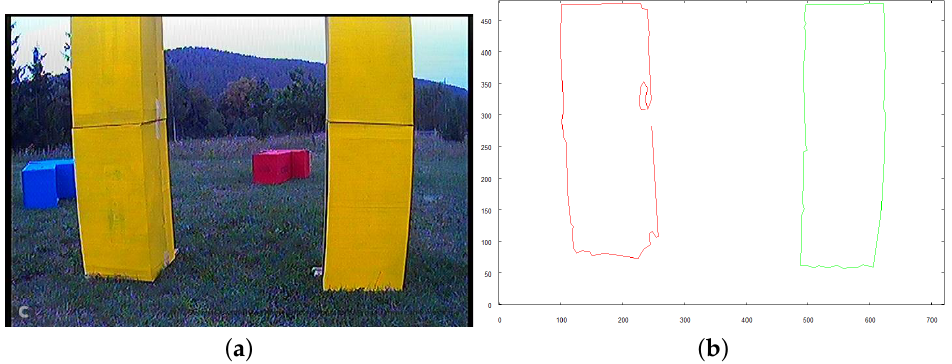
Figure 32. Robot approaching structure to fly underneath, 1.5 s after starting from initial position. ( a ) image from robot’s camera ( b ) vectorized image from camera.